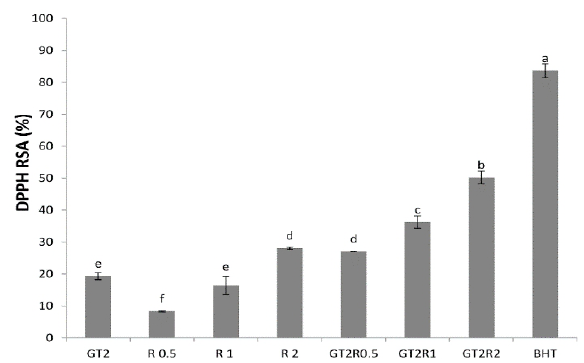
Fig. 1. DPPH Radical Scavenging Activity of Green Tea, Rosa damascena, and their infusions (Small letters show significant differences [P<0.05] among the DPPH scavenging activity of the samples; BHT (2 mg/ml) as the positive control)